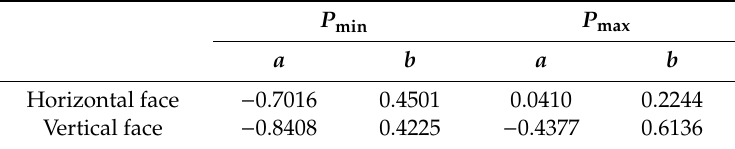
Table 3. Coe ffi cients in Equation